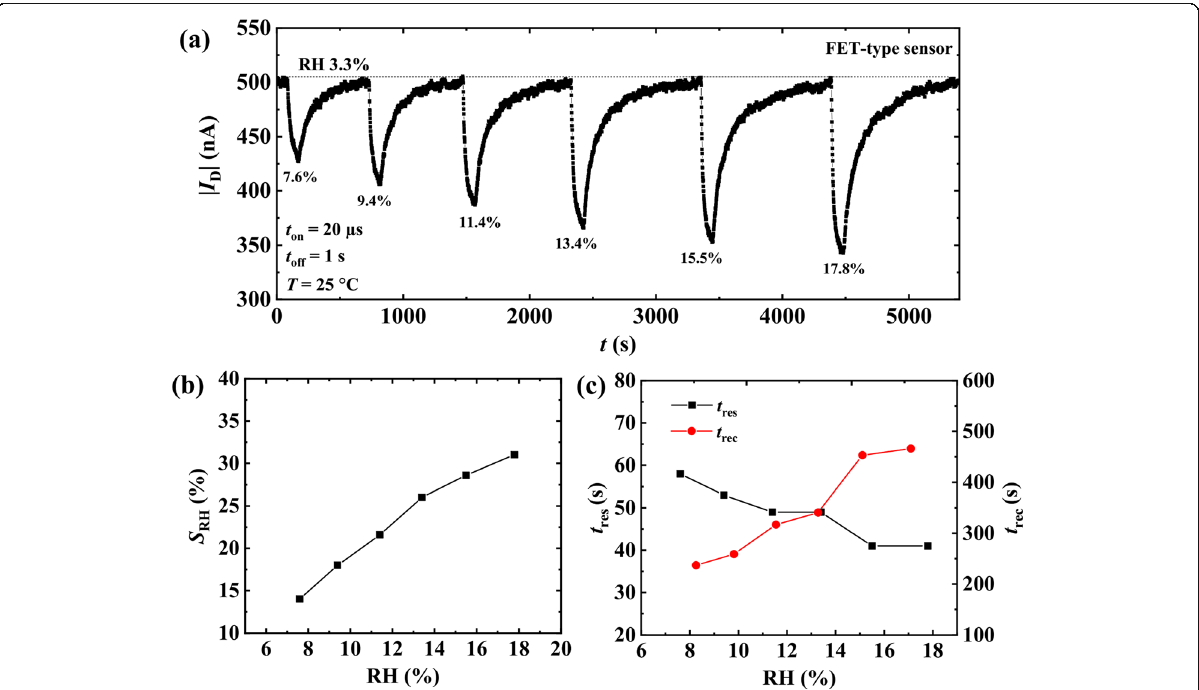
Fig. 5 Humidity detection using the proposed FET-type sensor. a Transient humidity sensing measurement at T = 25 °C. RH = 3.3%, 7.6%, 9.4%, 11.4%, 13.4%, 15.5%, and 17.8%. b S RH as a parameter of RH in a range from 3.3 to 17.8%. c Variations of t res and t rec of the FET-type sensor with RH